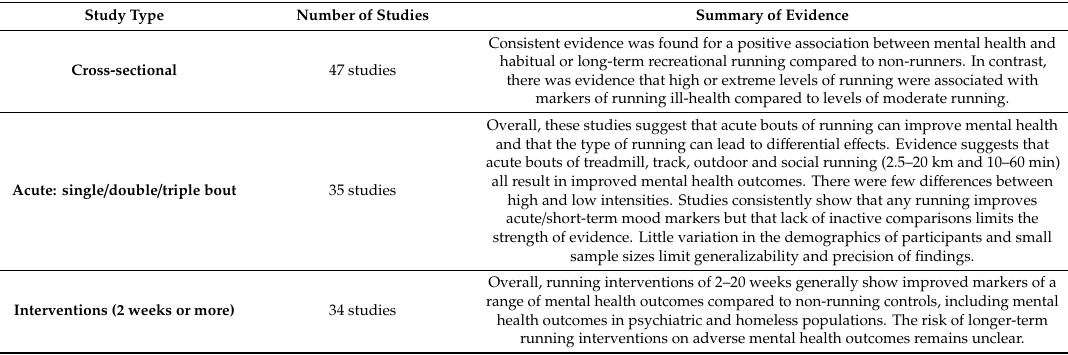
Table 7. Summary of key findings within each of the three